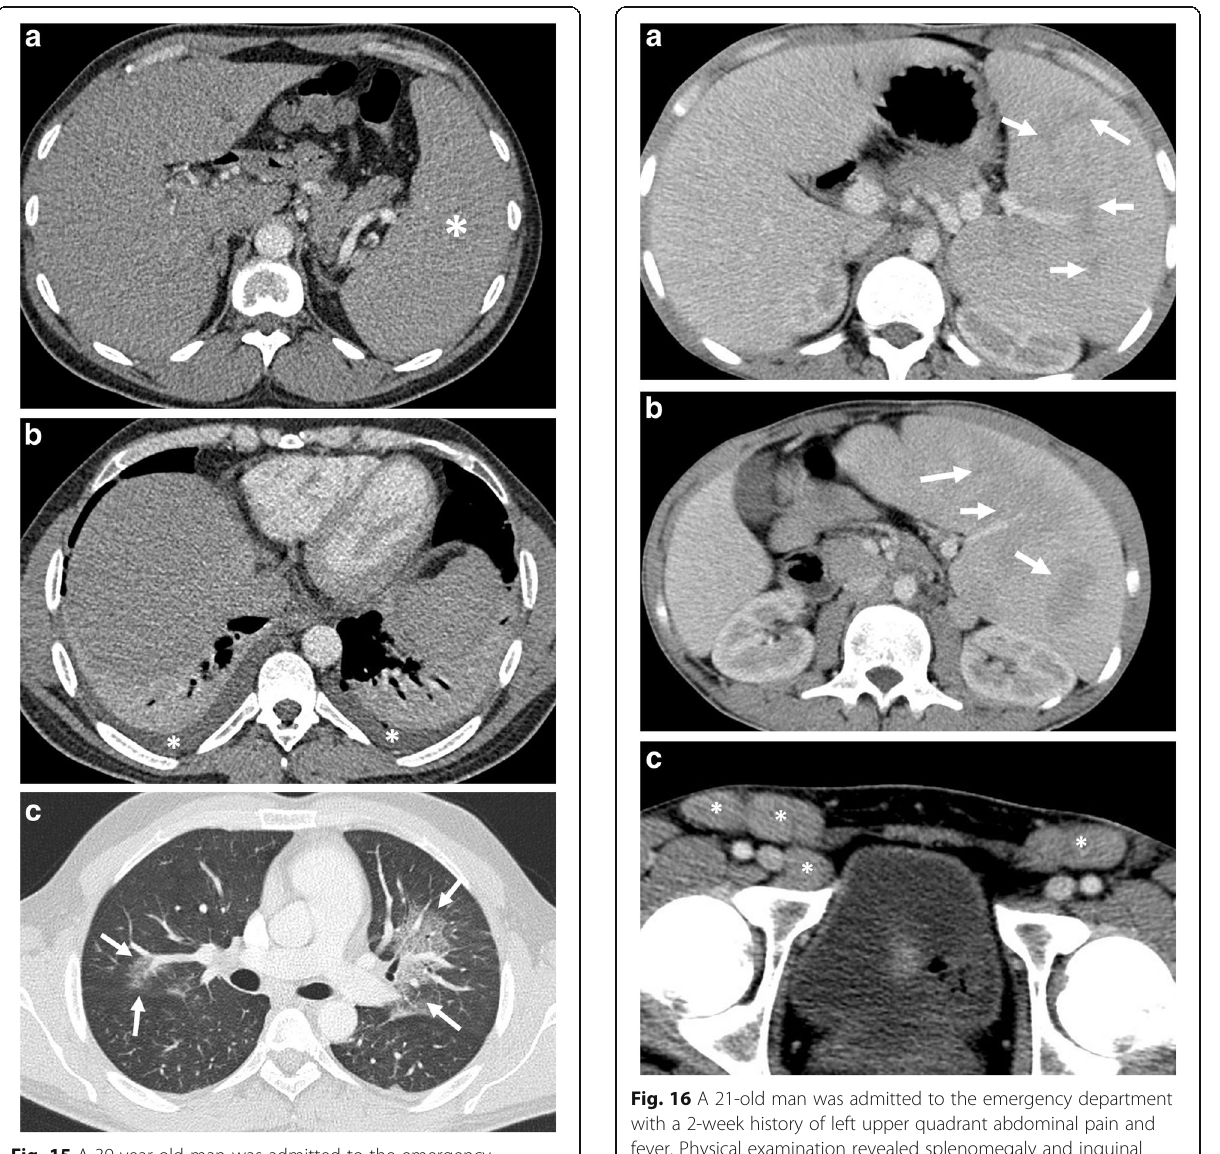
Fig. 15 A 39-year-old man was admitted to the emergency department with a 1-week history of mild abdominal pain and fever. Physical examination was unremarkable except for splenomegaly. Blood analysis demonstrated thrombocytopenia. a Axial contrast- enhanced CT image shows splenomegaly (asterisk). There was no sign of splenic infarction, hematoma, and rupture at the time of diagnosis. b , c CT scan of the chest showed bilateral mild pleural effusion (asterisks, b ) and centrally located ground-glass opacities (arrows, c ). The findings raised suspicion for non-cardiogenic pulmonary edema. The imaging findings were not specific for any particular type of disorder. Nevertheless, the final diagnosis was made by a peripheral blood smear examination showing the plasmodium falciparum infection